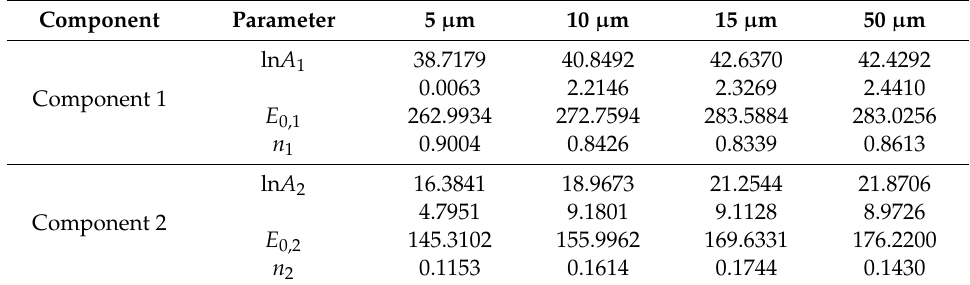
Table 5. Distributed activation energy method (DAEM) fitness for di ff erent particle size with di ff erent heating